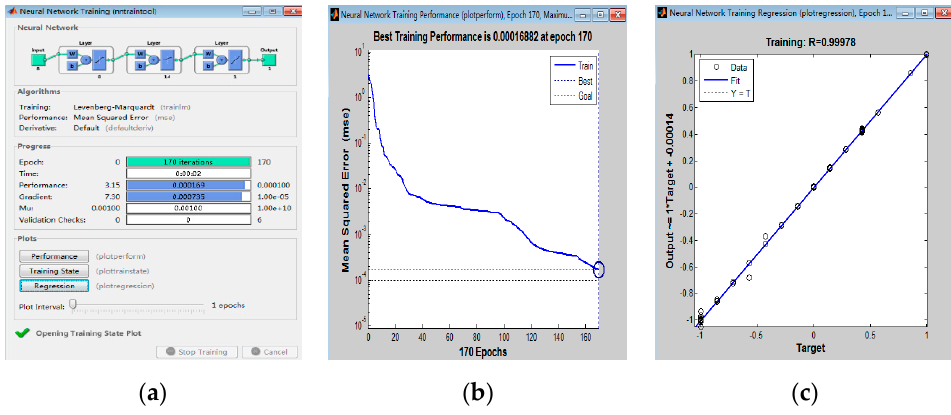
Figure 7. Training diagram: ( a ) process; ( b ) mean square error; ( c ) regression fitting.